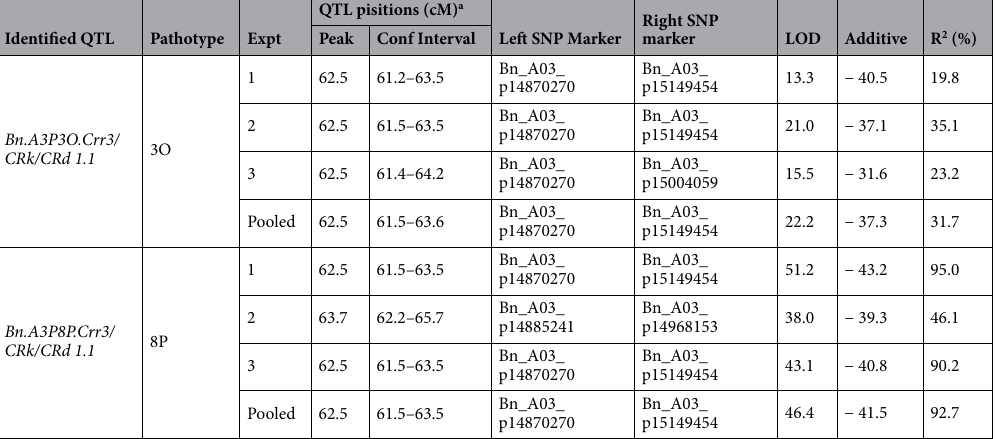
Table 4. Summary of QTL on chromosome A03 associated with clubroot resistance in doubled haploid lines derived from the Brassica napus cv. ‘Tosca’ inoculated with different Plasmodiophora brassicae pathotypes using ‘Mendelian’ and ‘distorted’ markers. a QTL positions based on two-LOD support intervals for 99% confidence interval (CI), (Lander and Botstein 52 ).